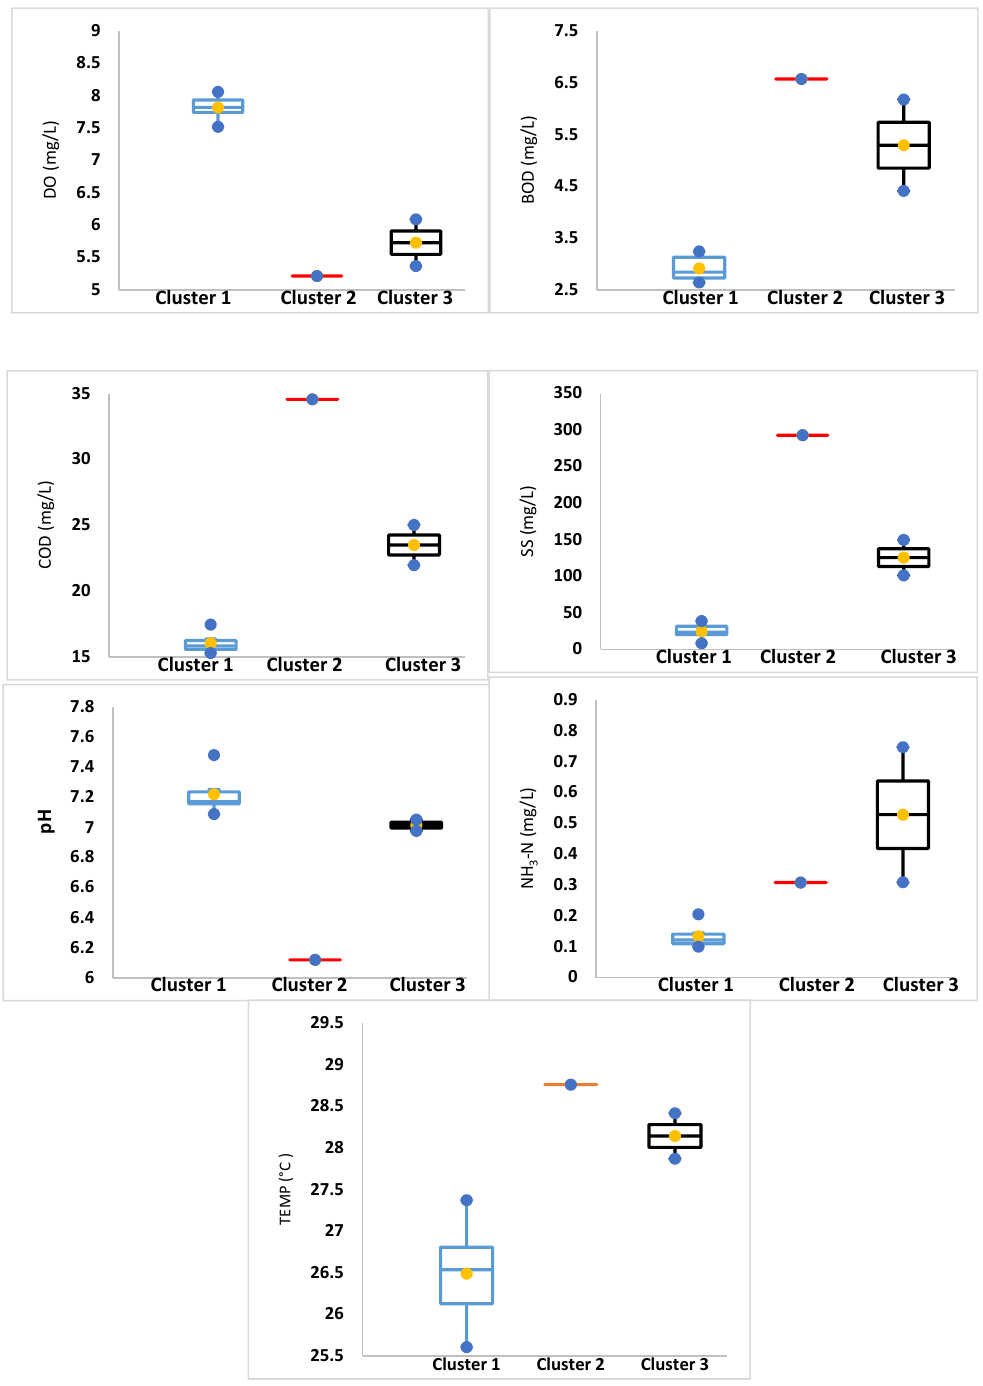
Fig. 3: Box-and-whisker plots of the spatial variations in the discriminant water quality variables. The central horizontal bars are the medians and the lower and upper edges of the box are respectively the first and third quartiles. The dots above or below the upper and lower edges of whiskers can be considered outliers. The dots in blue are the minimum and maximum for each variable. Cluster 2 has a regular red line shape, which signifies this cluster contains only one